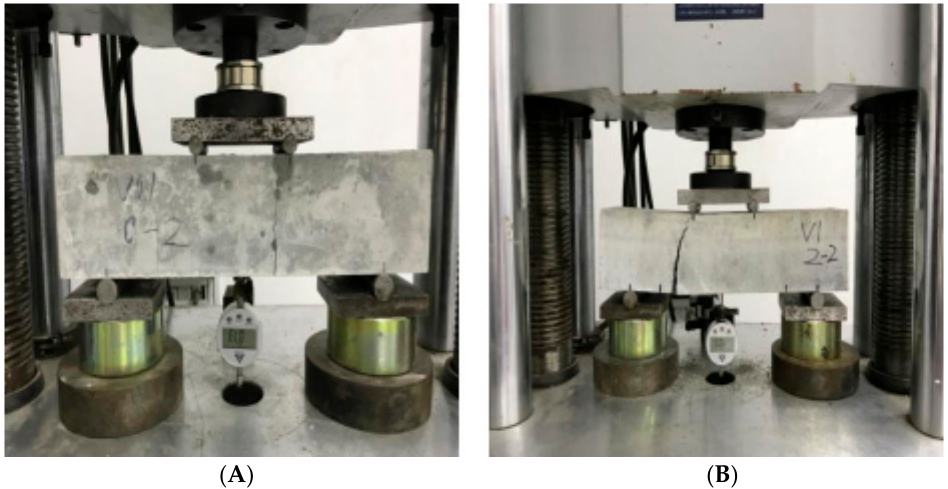
Figure 3. Data acquisition of steel fiber reinforced concrete crack. ( A ) Initiative crack image; ( B ) biggest crack image. ( B ) biggest crack